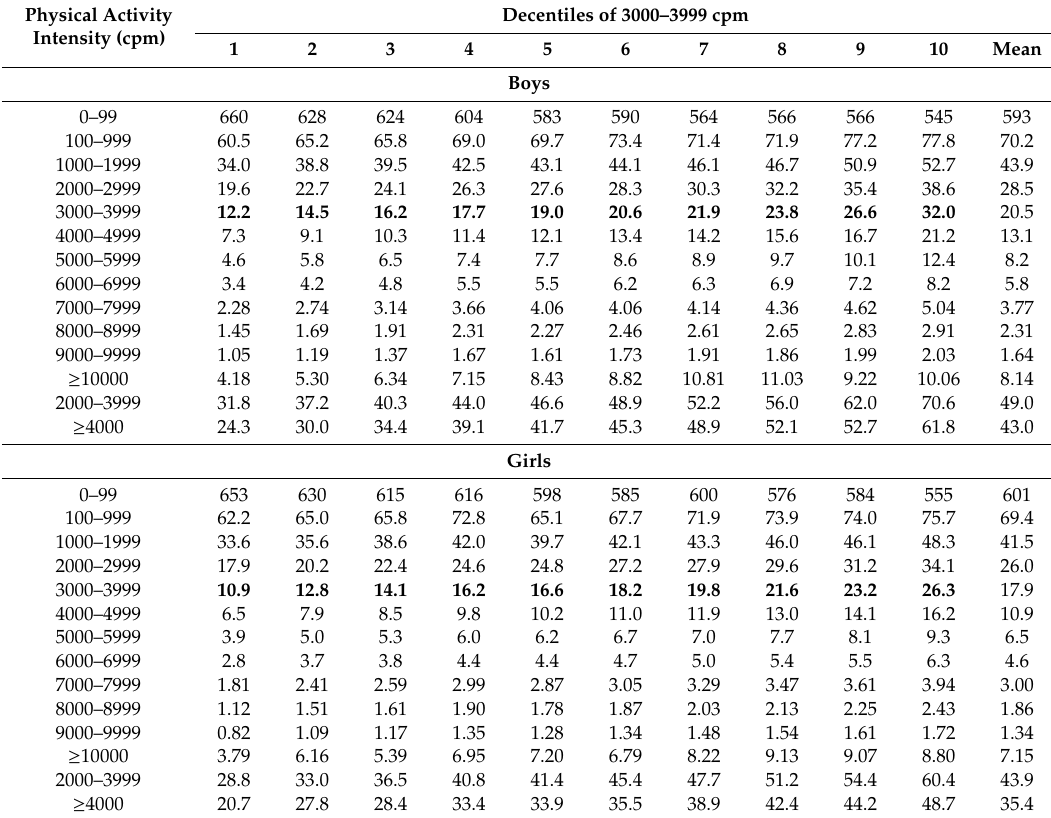
Table 3. Mean time (min / day) spent in PA intensities according to decentiles of time spent in 3000–3999